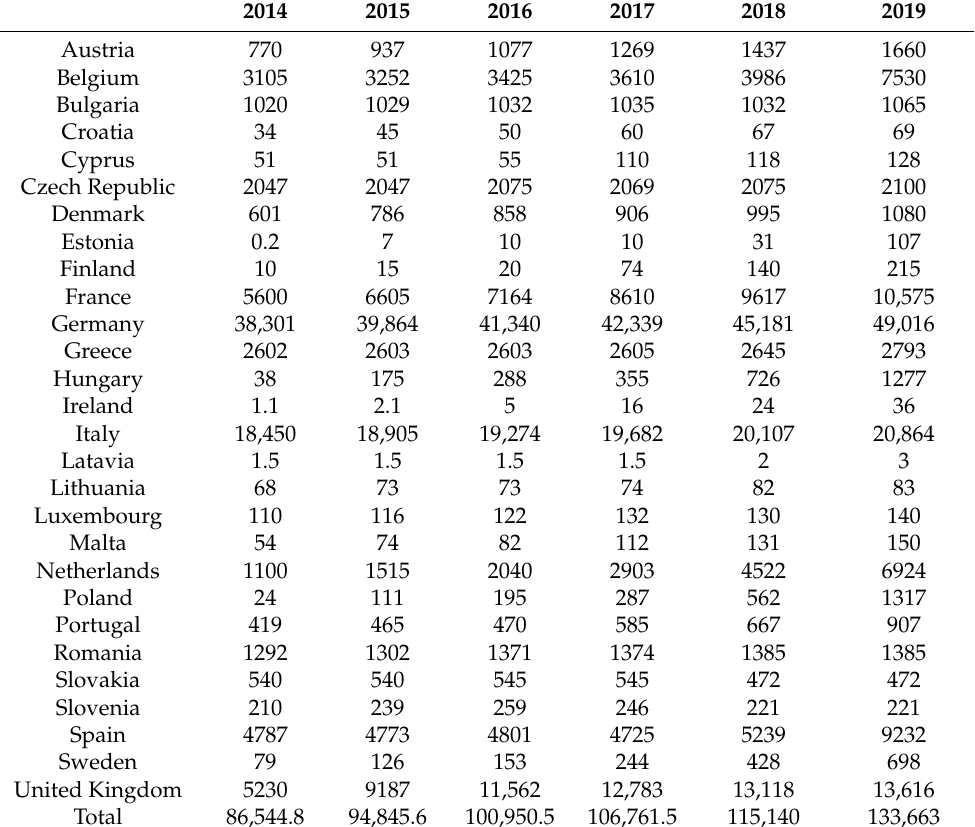
Table 1. Photovoltaic capacity in European Union countries in years 2014–2019